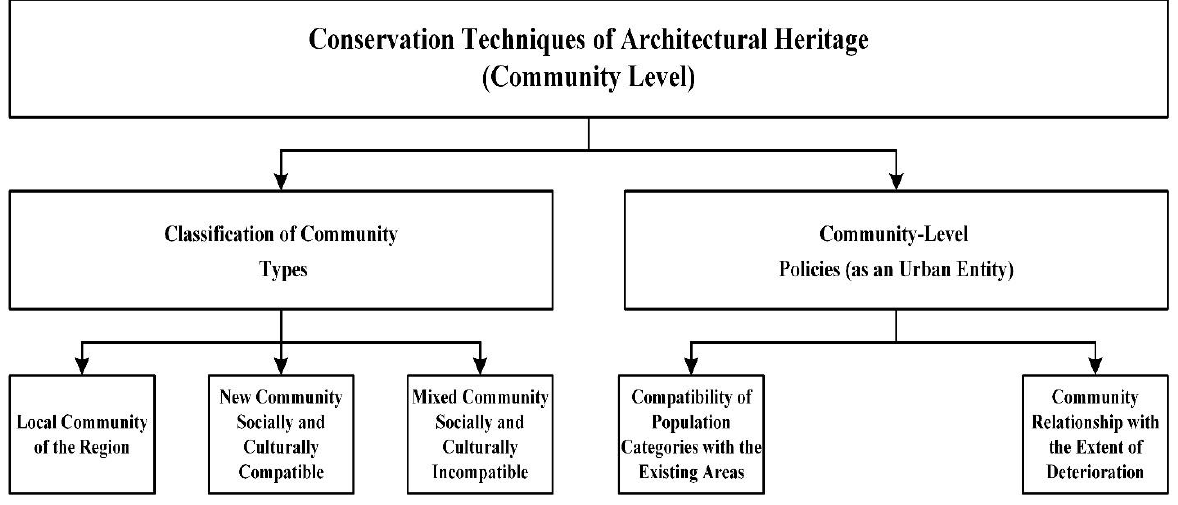
Figure 3: The conservation techniques of architectural heritage – Community level